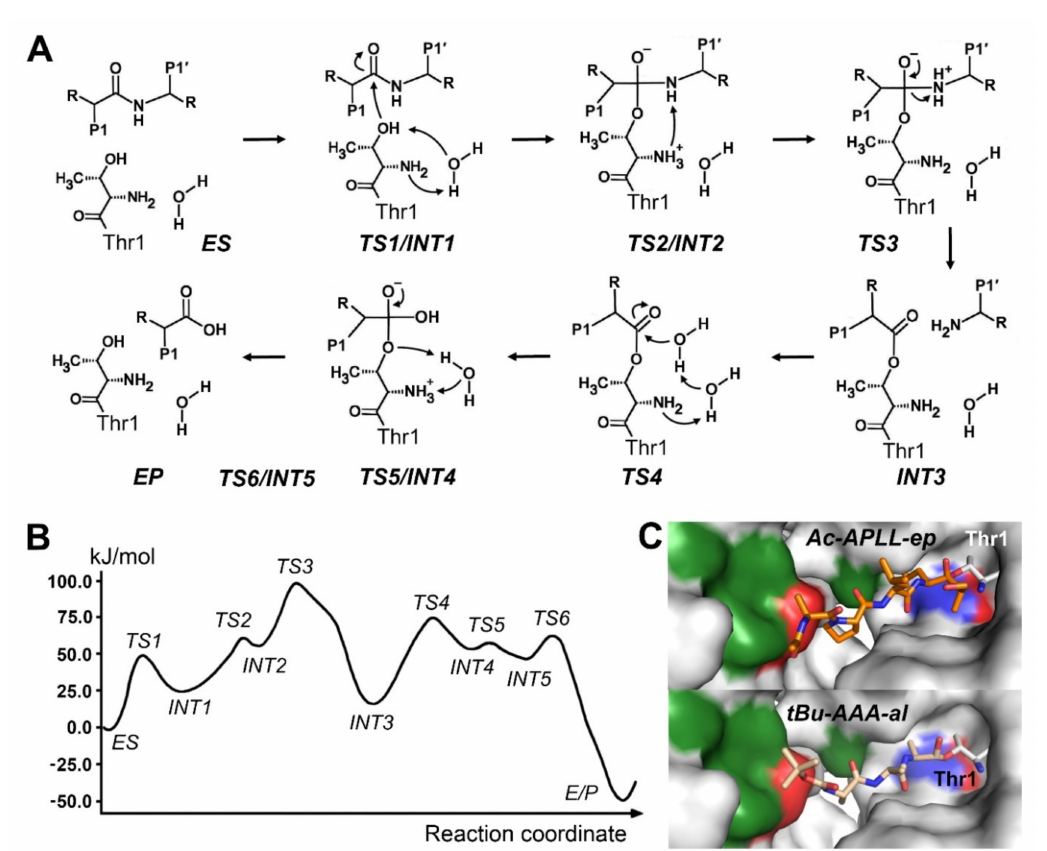
Figure 6. Mechanistic details of threonine protease catalysis. ( A ) The six step mechanism according to Wei et al., 2013 [175]. ( B ) Free energy profile of the six-step reaction. ( C ) Inhibitor structures of the yeast 20S proteasome. Upper panel: The epoxide Ac-Ala-Pro-Leu-Leu-ep covalently bound to the Thr1 O γ atom of the β 5 subunit corresponds to the tetrahedral intermediate INT2. The α N-C bond is not shown for clarity in the upper panel (PDB 4QBY). Lower panel: The tBu-Ala-Ala-Ala-aldehyde bound to Thr1 represents the acyl intermediate INT3 (PDB